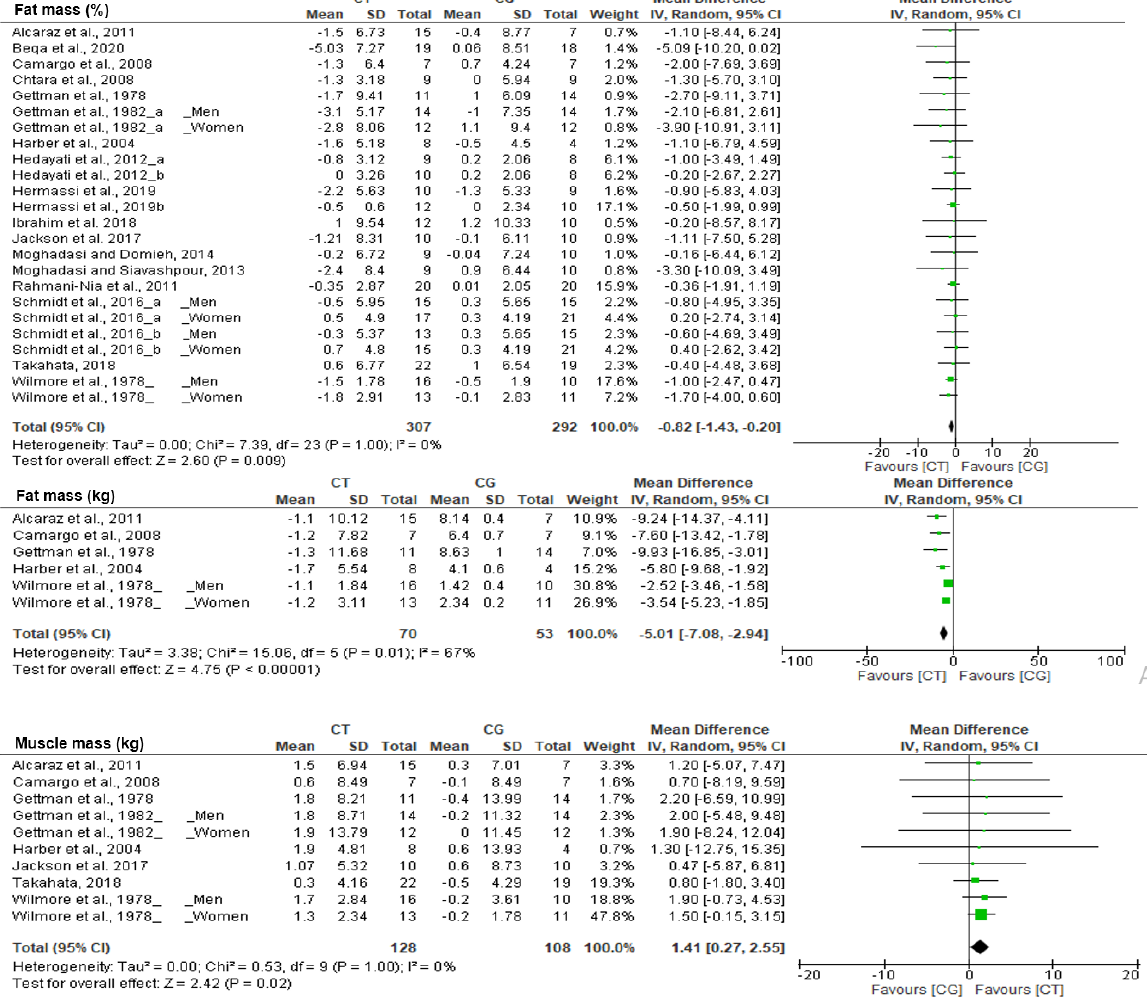
Figure 2. Results of a random effects meta-analysis for resistance circuit training (CT) compared to control group (CG), shown as mean difference and standardized mean difference with 95% CIs on body composition. Table 2. Effect of resistance circuit training and endurance training on body composition outcomes.